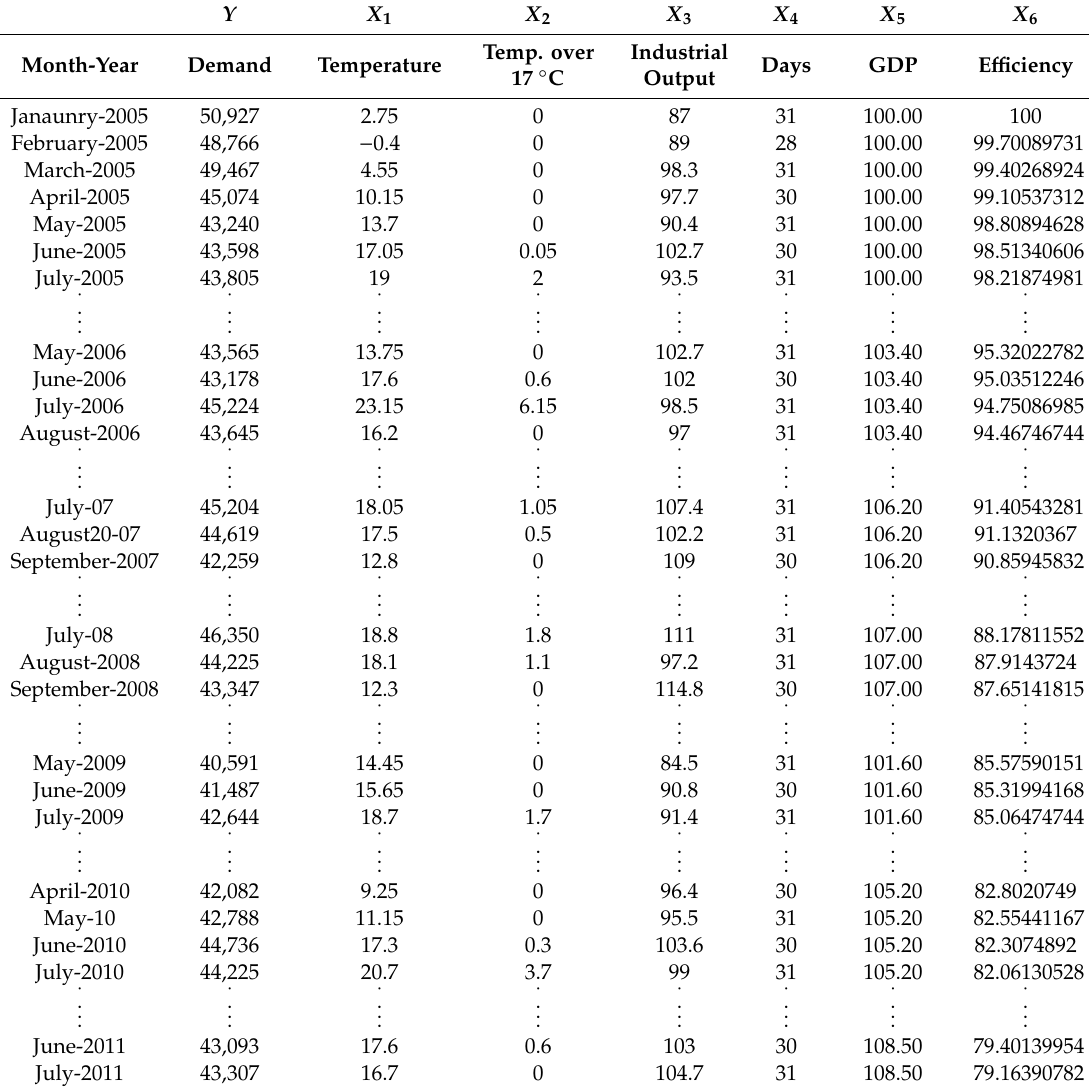
Monthly data regarding the German market from 2005 until April 2013 used for regression